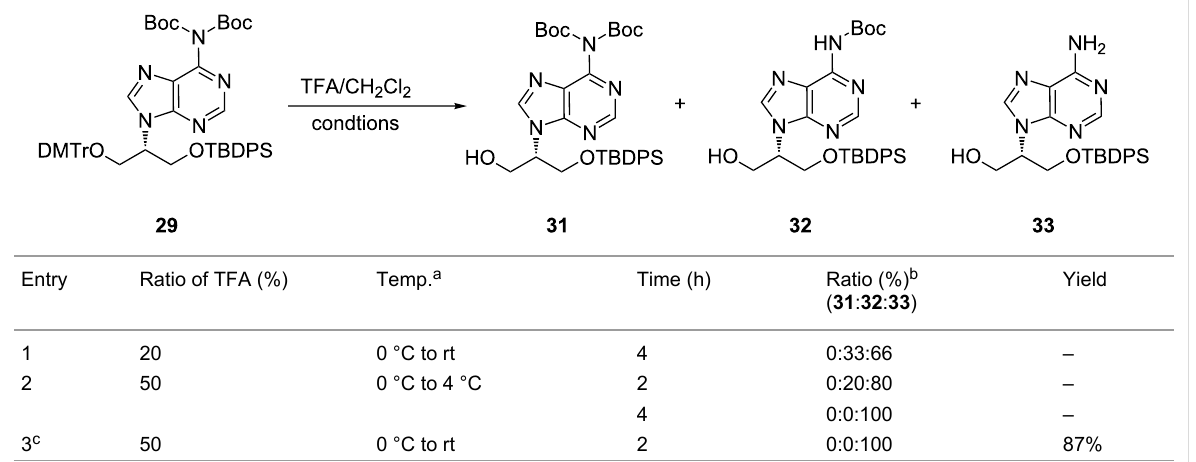
Table 1: Result of Boc deprotection of 29 with